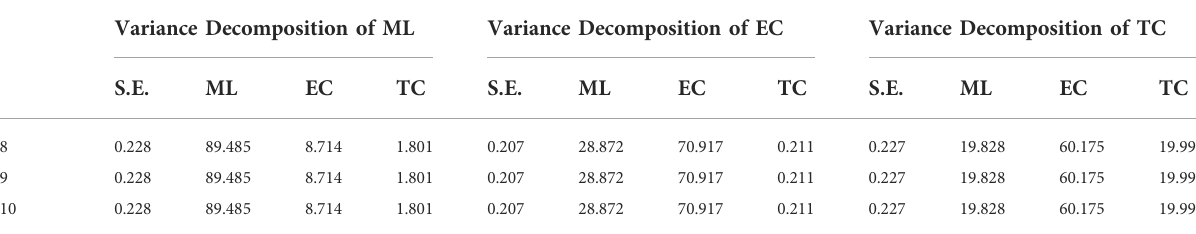
TABLE 9 ( Continued ) Variance decomposition of ML , EC and TC of DEIECE in various regions. Period